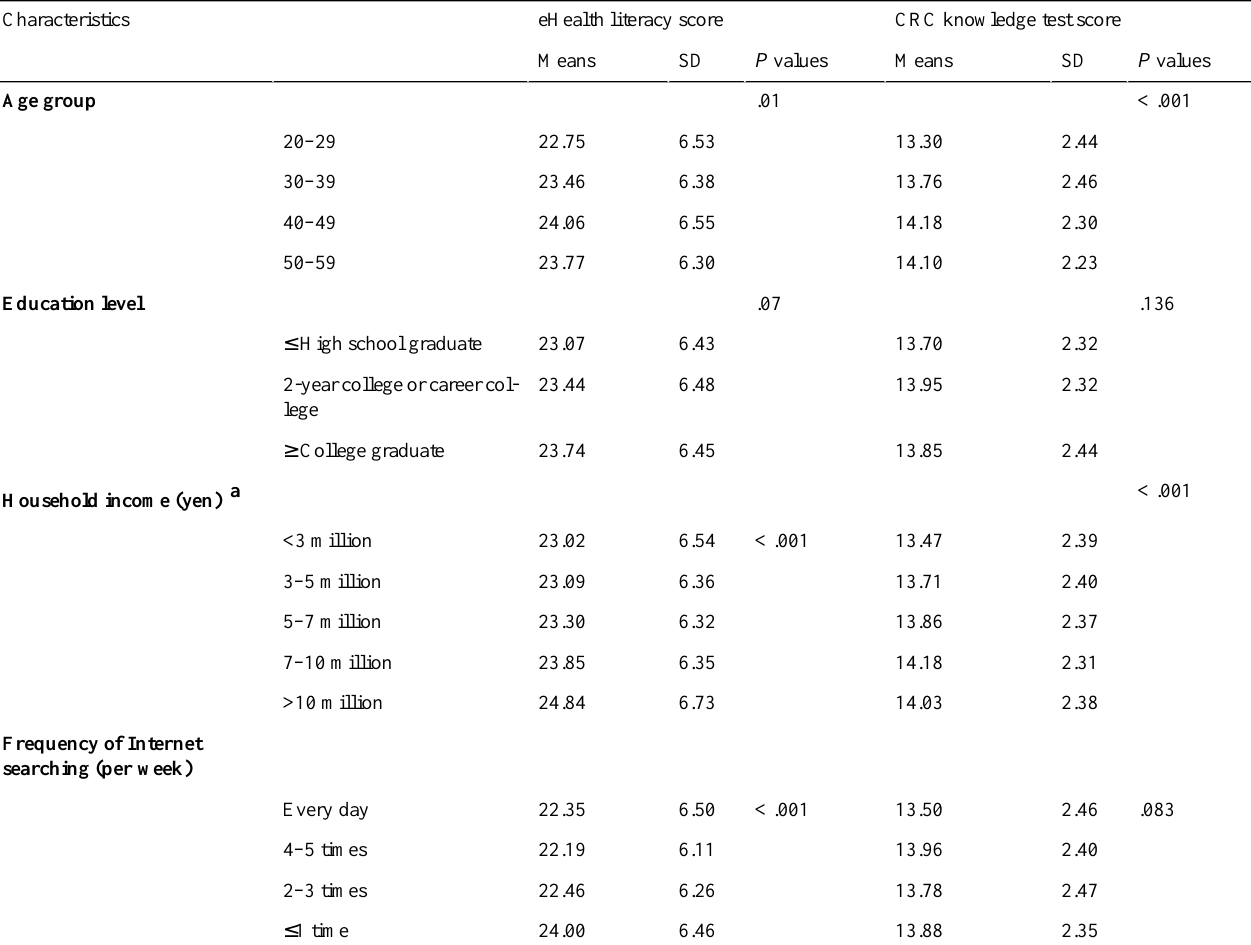
Table 3. Association of eHealth literacy and knowledge of CRC with age, educational level, household income and frequency of Internet searching (using the one-way